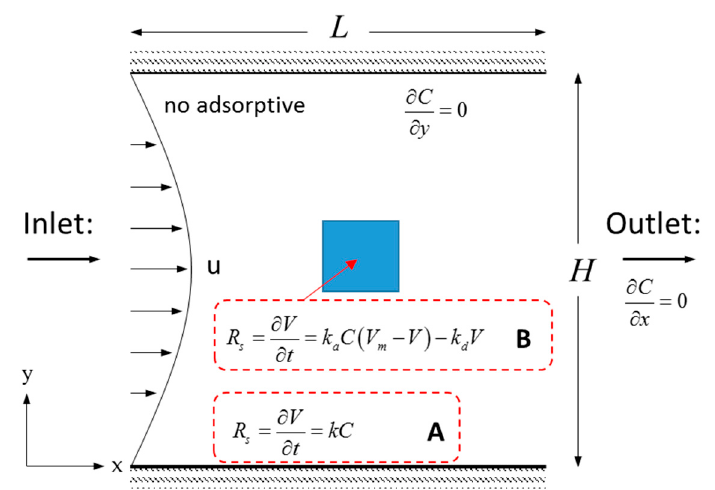
Figure 2. Diagram of the convection–diffusion system with surface adsorption reaction.